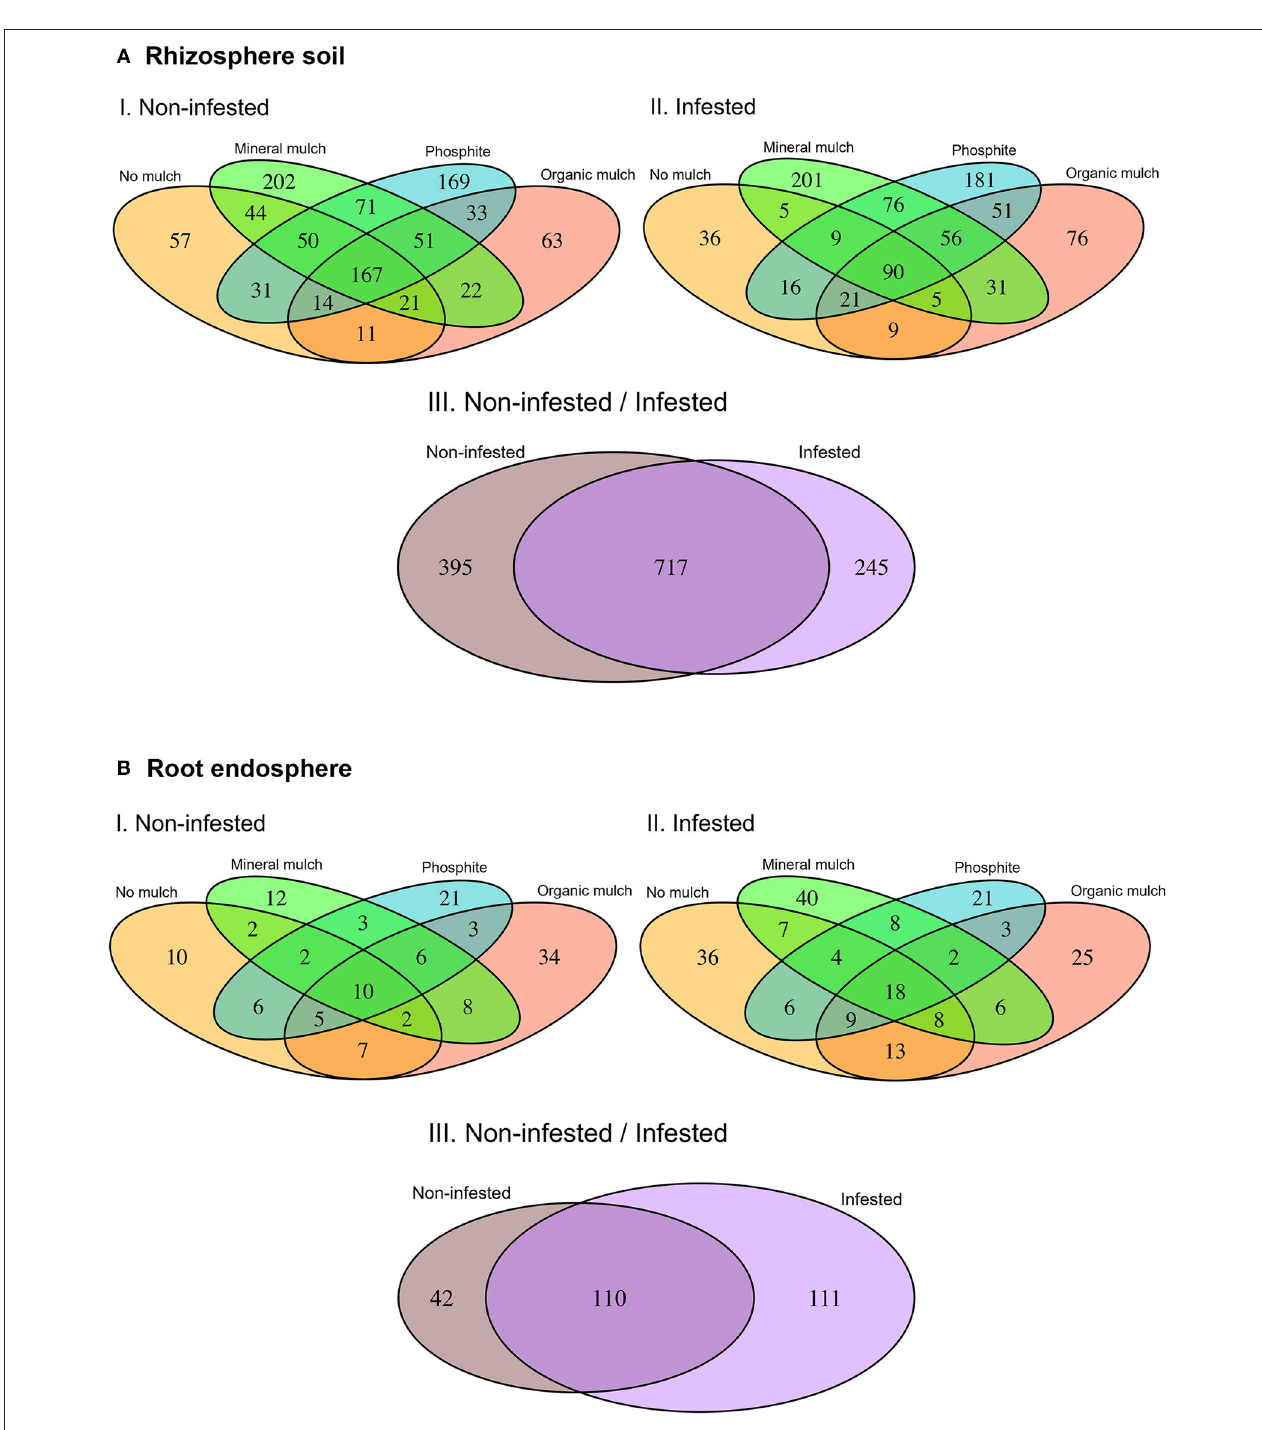
FIGURE 5 | Venn diagrams representing the operational taxonomic units (OTUs) in common and different in the microbiome of (A) rhizosphere soil and (B) root endosphere among treatments.